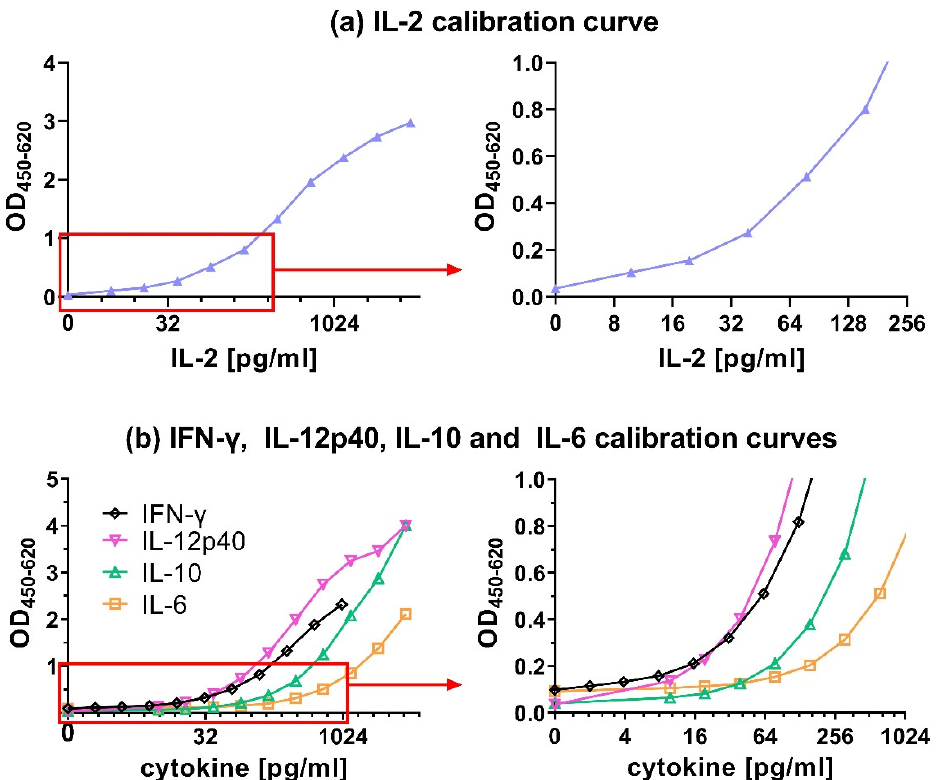
Figure 4. Calibration curves for recombinant chicken ( a ) IL-2, ( b ) IL-6, IL-10 and IL-12p40 ranging from 9.8 to 5000 pg/mL, and IFN- γ ranging from 2 pg/mL to 1000 pg/mL presented at the full concentration range (left graphs) and the lower concentration range up to 1.0 OD (right graphs). All results represent absorbance signals.